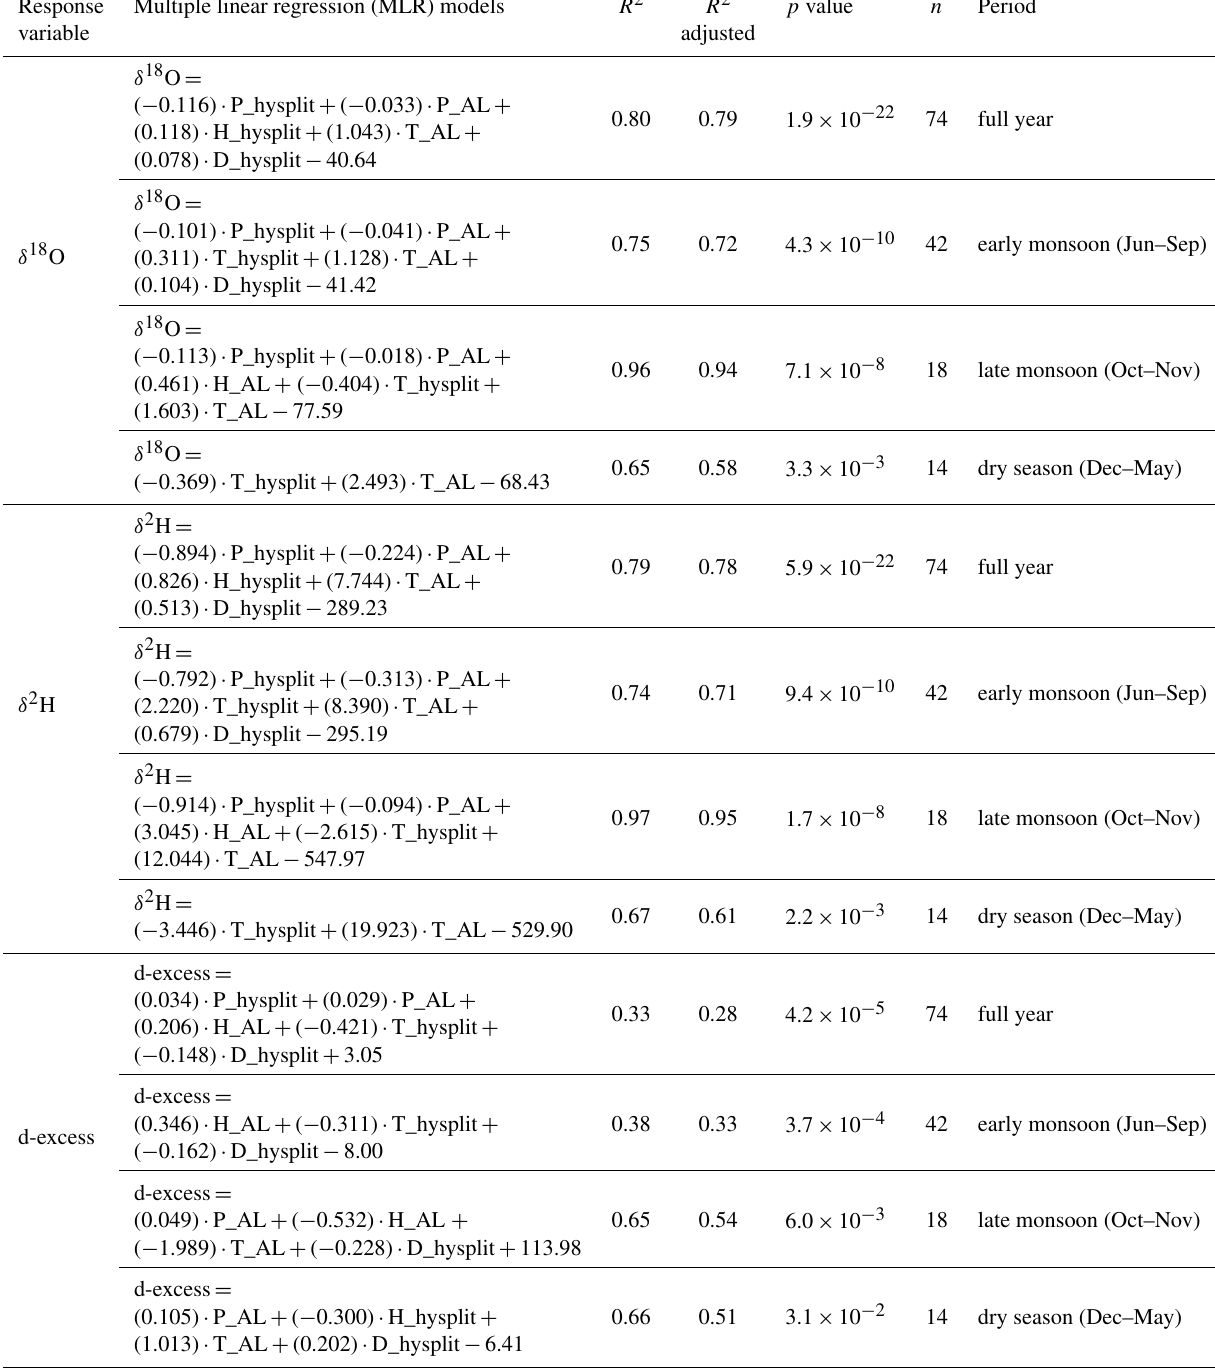
Table 5. The final best models (both for annual and seasonal analyses) for δ 18 O, δ 2 H, and d-excess as the response variable in MLR.